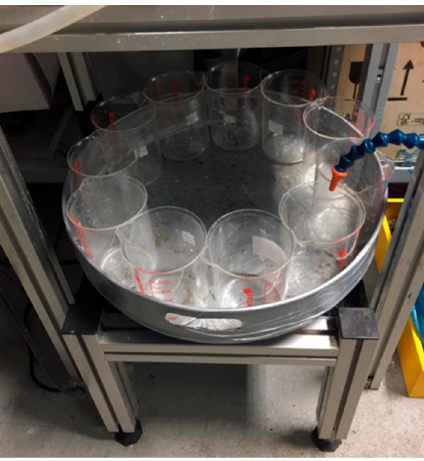
6 of 17 Table 1. The parameters for the effluent collection table. Effluent Collection Table Parameters